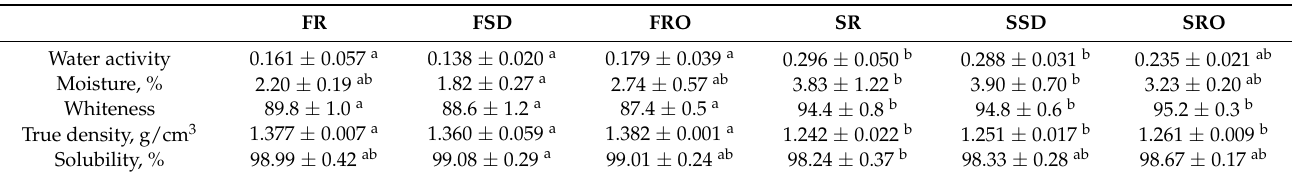
Table 1. Selected physicochemical properties of camel milk